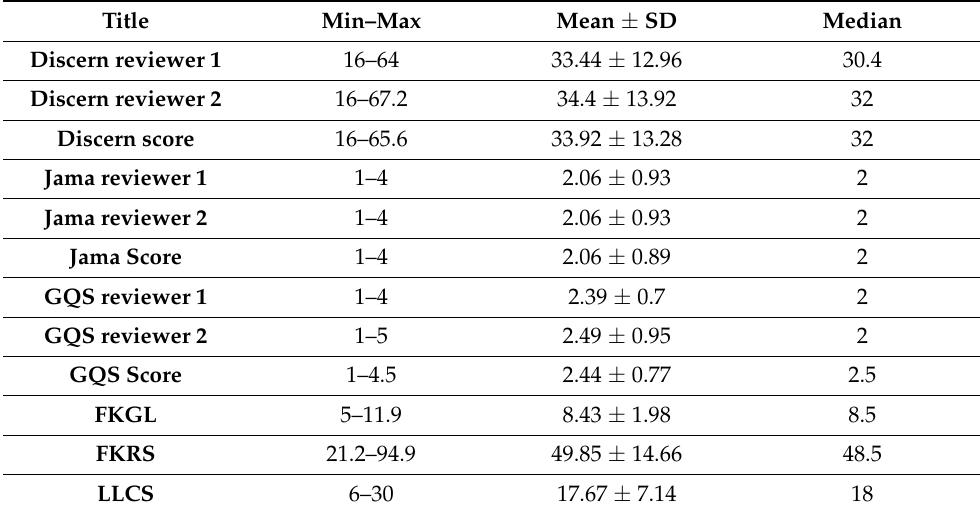
Table 2. Minimum, maximum, mean, standard deviation and median values of scores.